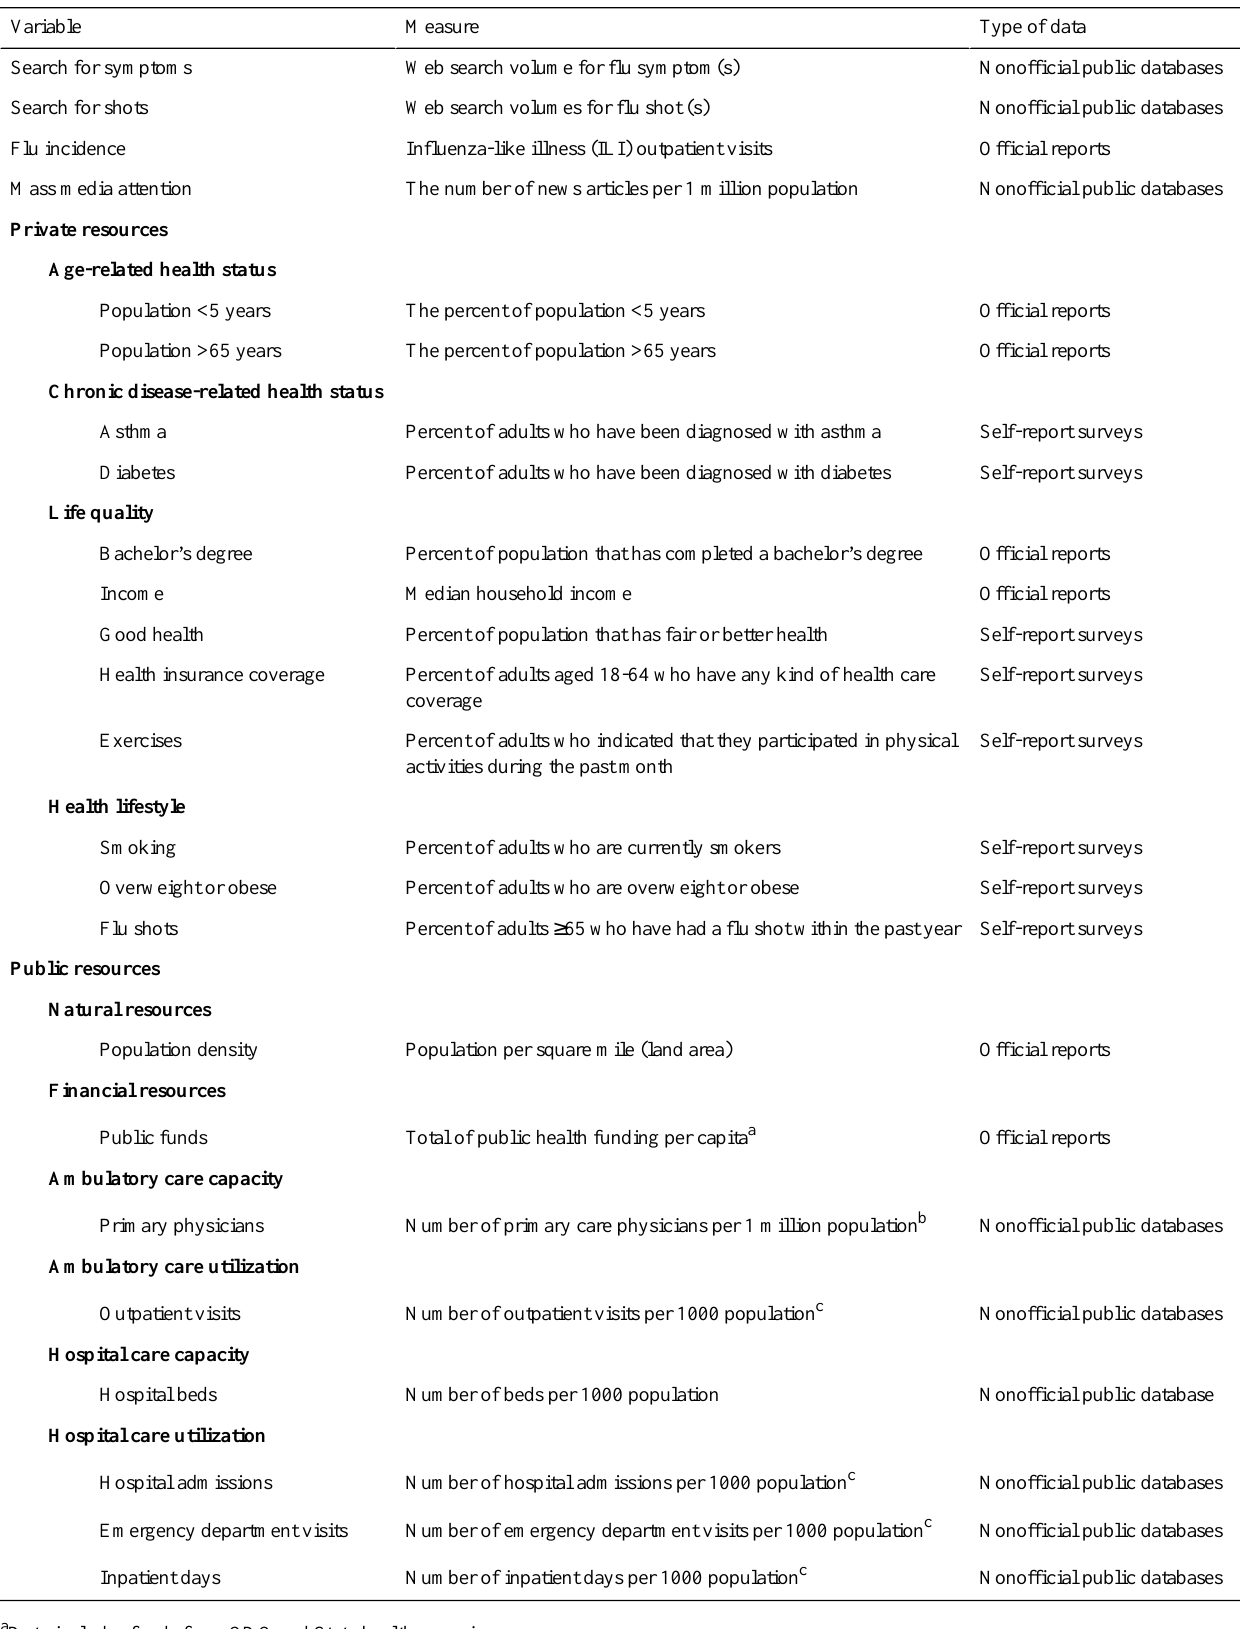
Table 1. Study variables: measures and types of data.